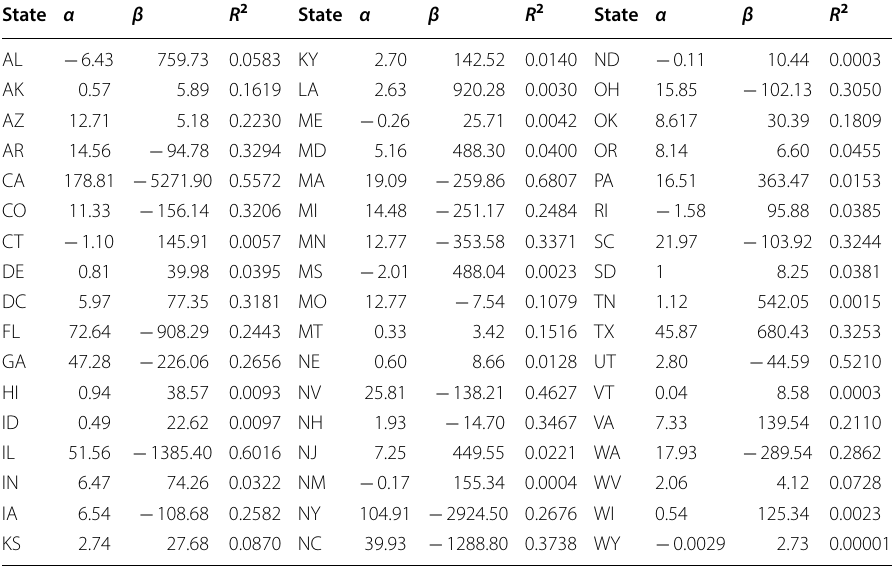
Table 6 Coefficients α , β , and R 2 of the linear regressions for Syphilis cases State